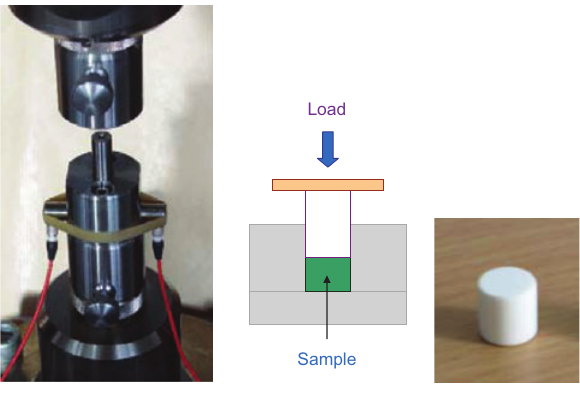
Figure 1 Confi ned compression set-up and sample.